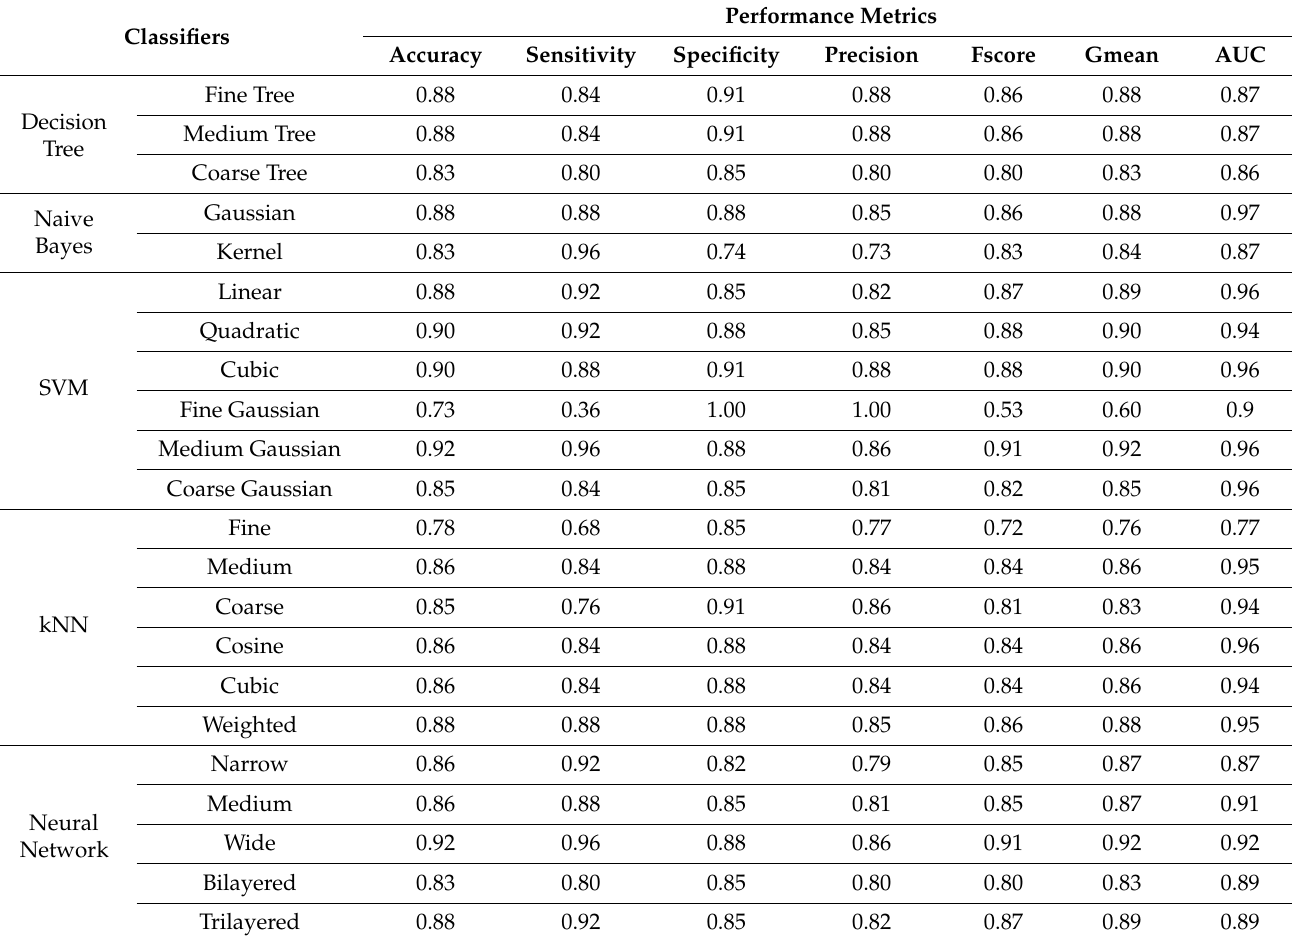
Table 8. Results for the best 50